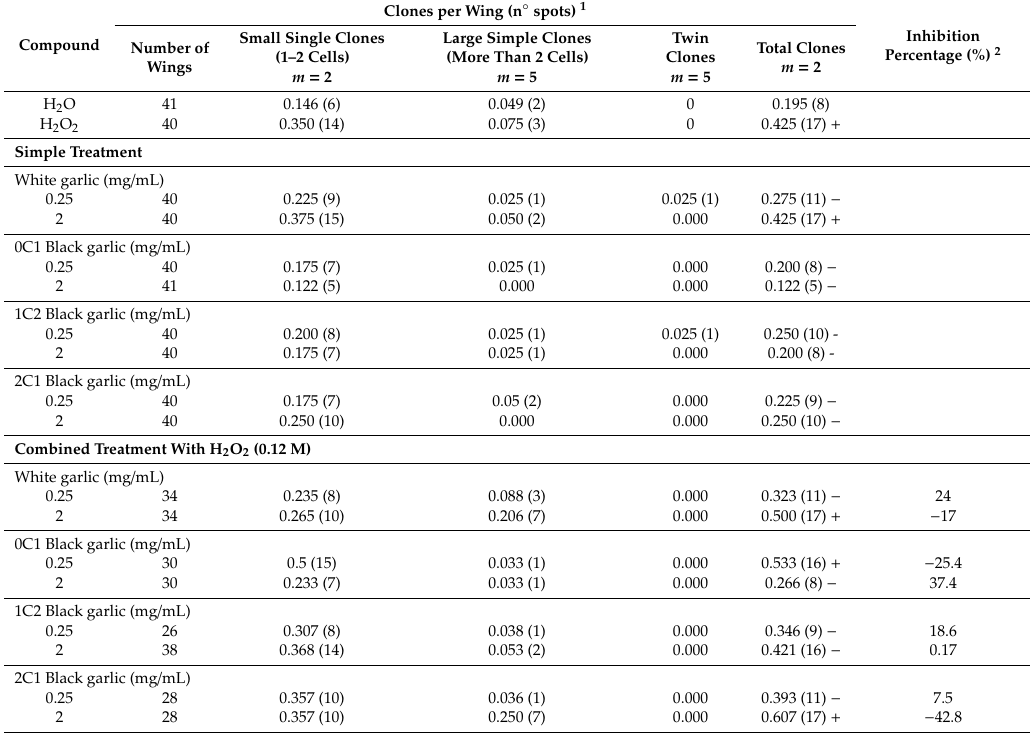
Table 2. Genotoxicity and antigenotoxicity of white (0 days aging), 0C1 black (13 days aging), 1C2 black (32 days aging), and 2C1 black (45 days aging) garlic in the Drosophila wing spot test. Clones per Wing (n ◦ spots) 1 Compound